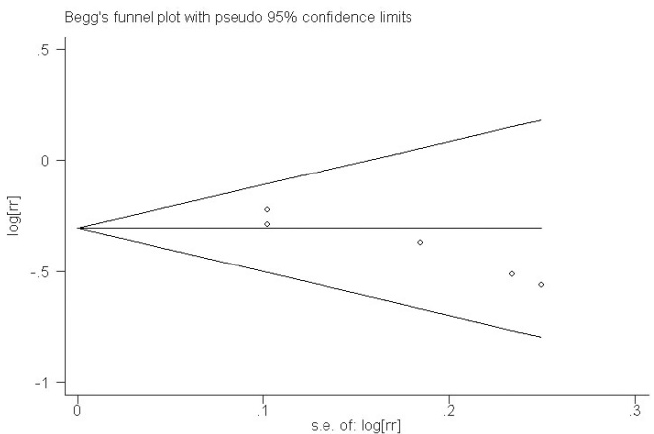
Figure 2. Funnel plot of the relative risk (for the longest duration of multivitamin/mineral supplementation versus no supplementation) versus the standard error of the log relative risk for studies evaluating nuclear